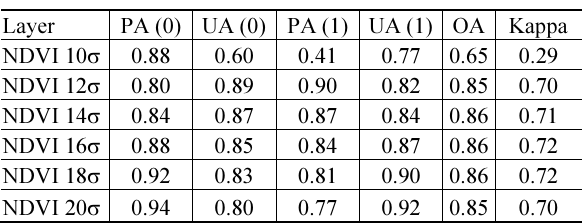
Table 2. Accuracies (PA: producer’s accuracy, UA: user’s accuracy, OA: Overall accuracy, 1: change, 0: no-